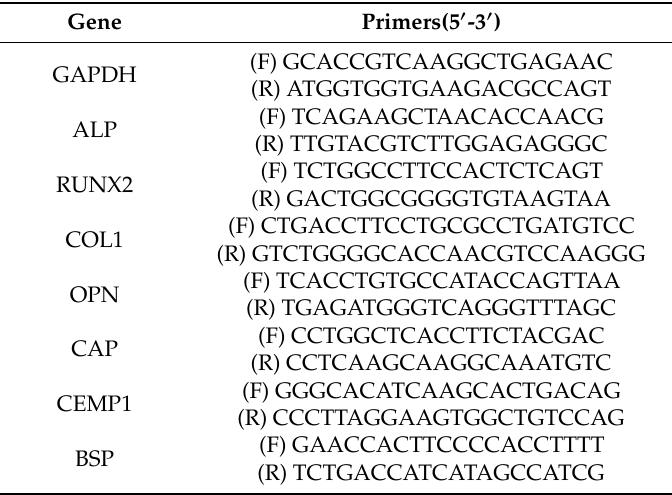
Table 1. List of primer sequences used in Real time